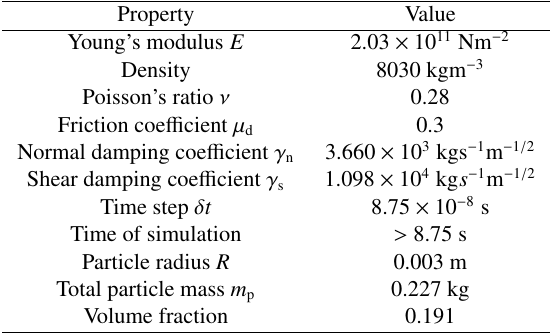
Table 1. Simulation parameters and material properties of the